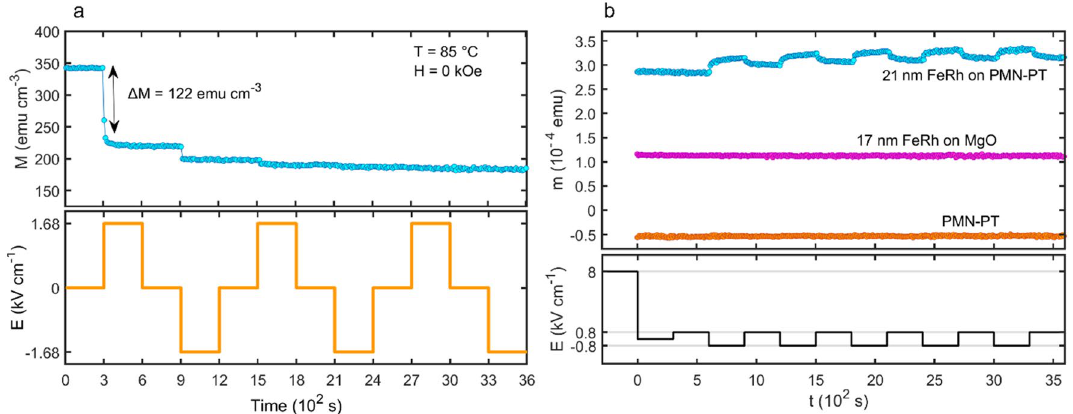
Figure 4. ( a ) The magnetisation of PMN-PT/FeRh as the applied electric field is switched between + 1.68 kV cm −1 and − 1.68 kV cm −1 . On first increasing the electric field, the magnetisation is significantly reduced by the strain mediated magnetoelectric effect. Subsequent changes to the field produce diminishingly small changes to the magnetisation due to the strain being in a highly remanent state. ( b ) Repeatable switching in PMN-PT is demonstrated by applying an alternating ± 0.8 kV cm −1 electric field after poling at + 8 kV cm −1 . Measurements were conducted at 85